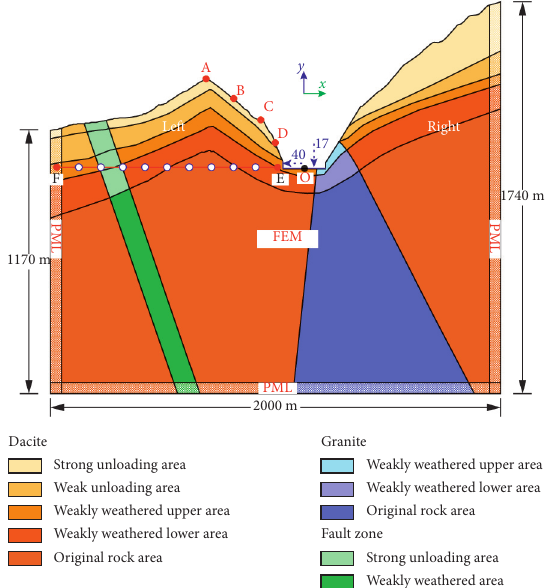
Figure 6: Numerical model of slope and layout of monitoring